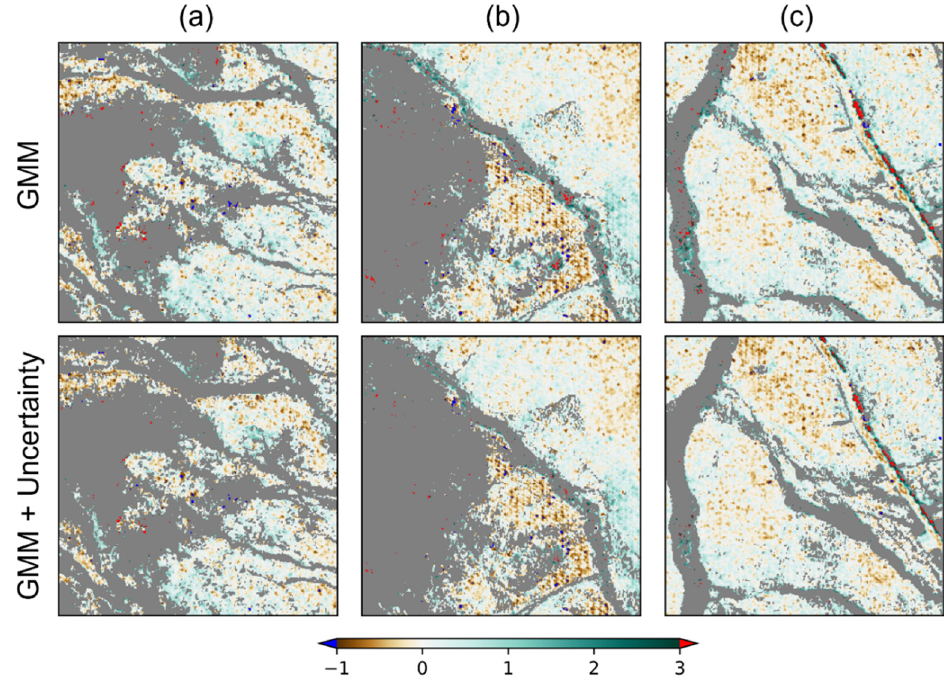
Figure 5. GMM-based ground masks overlaid with DEM differences (ArcticDEM—lidar-derived DTM), ( a – c ) correspond to Site-1, Site-2, and Site-3, respectively. The void areas displayed by grey color represent the non-ground locations in all ground masks. Positive DEM differences indicate vegetated areas. Here, GMM represents the identified pseudo-ground cluster and GMM + uncertainty indicates refinement by cluster membership probabilities.